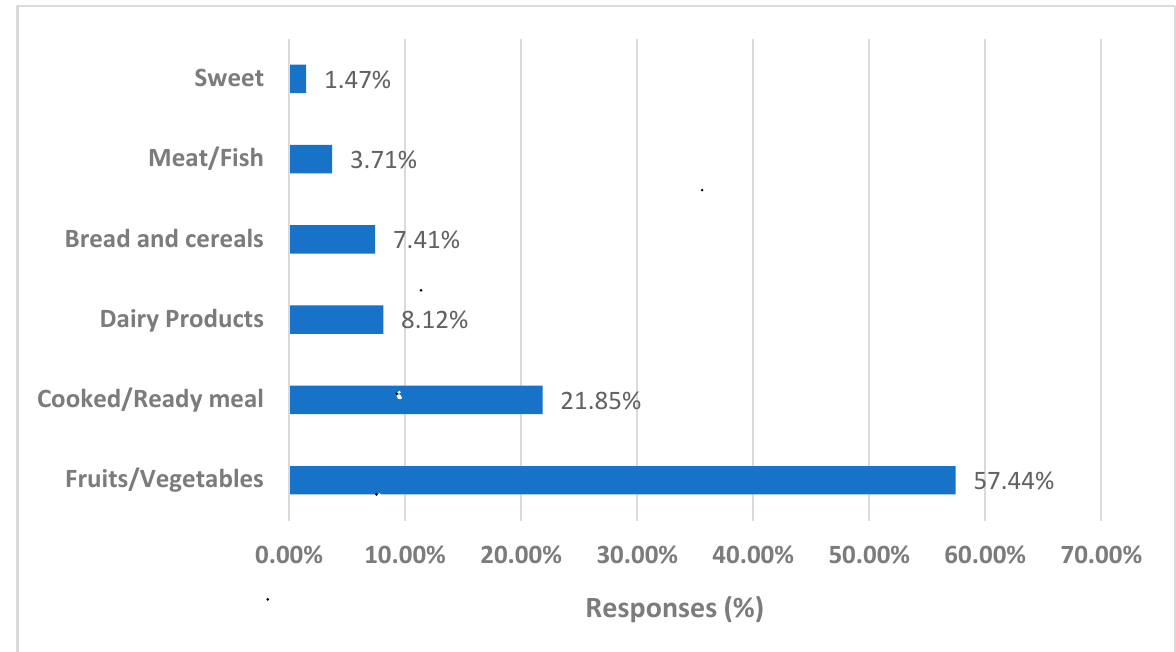
Figure 8. Responses to “Which food commodity is wasted the most from your household?”